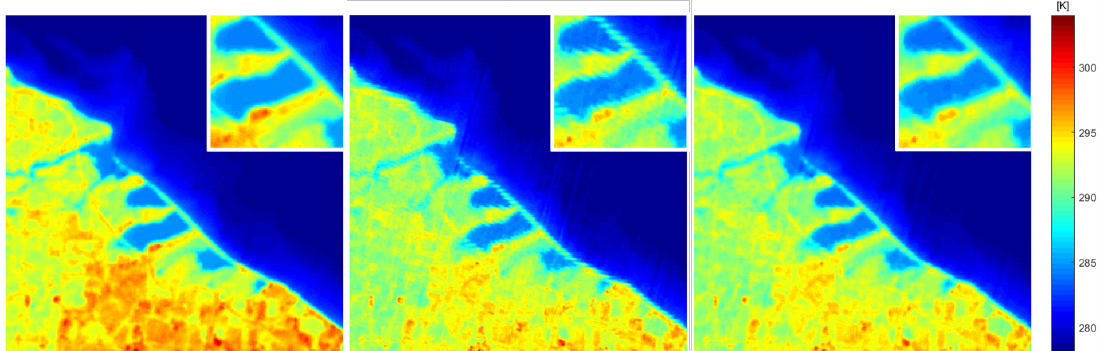
Figure 6. Comparison of surface temperature products: single channel product ( left ), the nominal split window product ( middle ), and the proposed split window product ( right ) (Landsat scene ID: LC08_L1TP_016030_20190413_20190422_01_T1). The scene is roughly 8 by 8 km, and north is up.